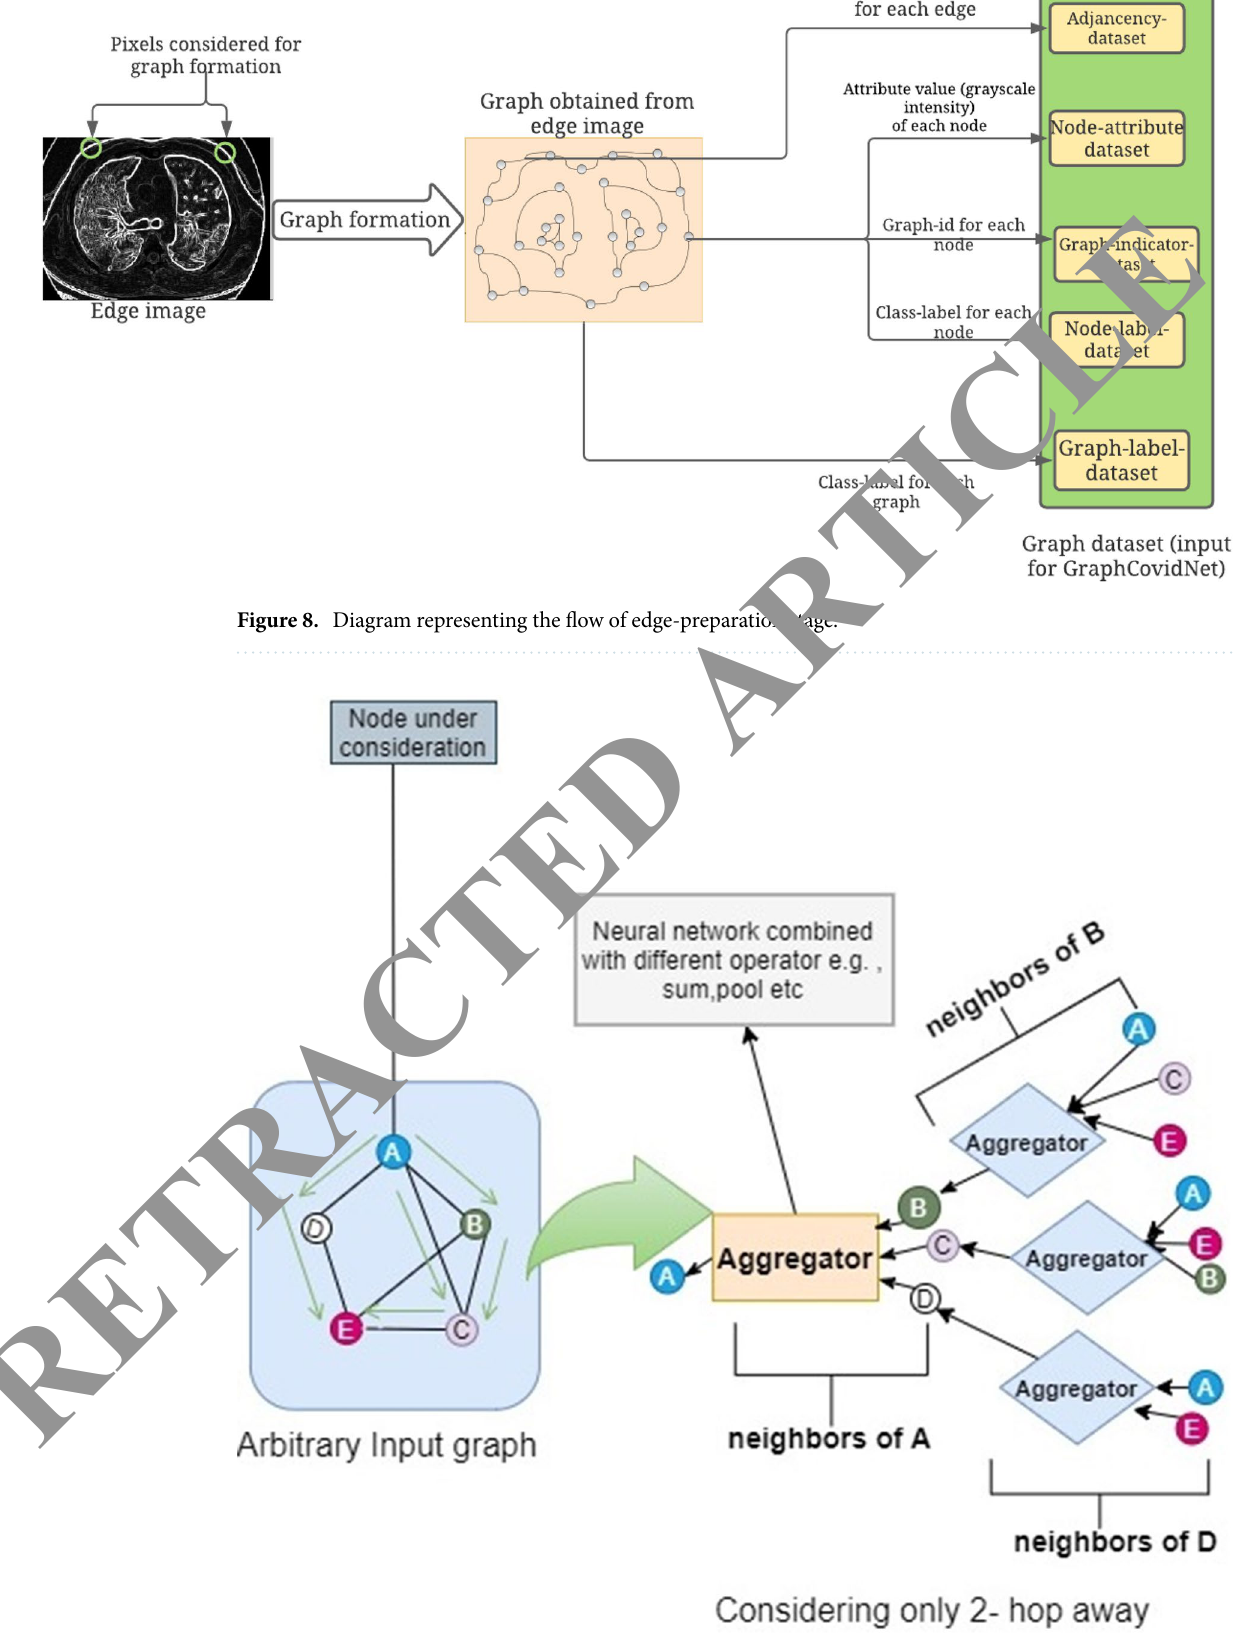
Figure 9. Diagram representing the computation graph of a node in an arbitrary